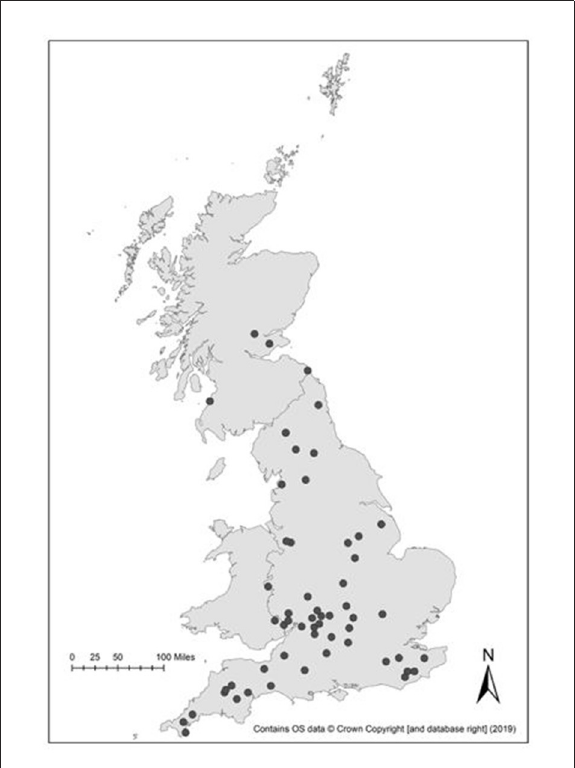
FIGURE1 Locations of PFLA member farms included in the